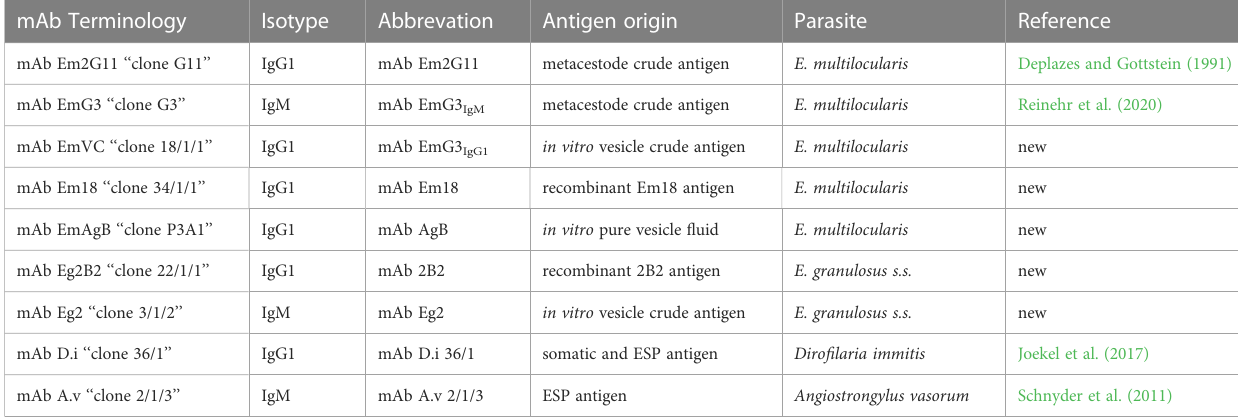
TABLE 1 Terminology and origin of monoclonal antibodies